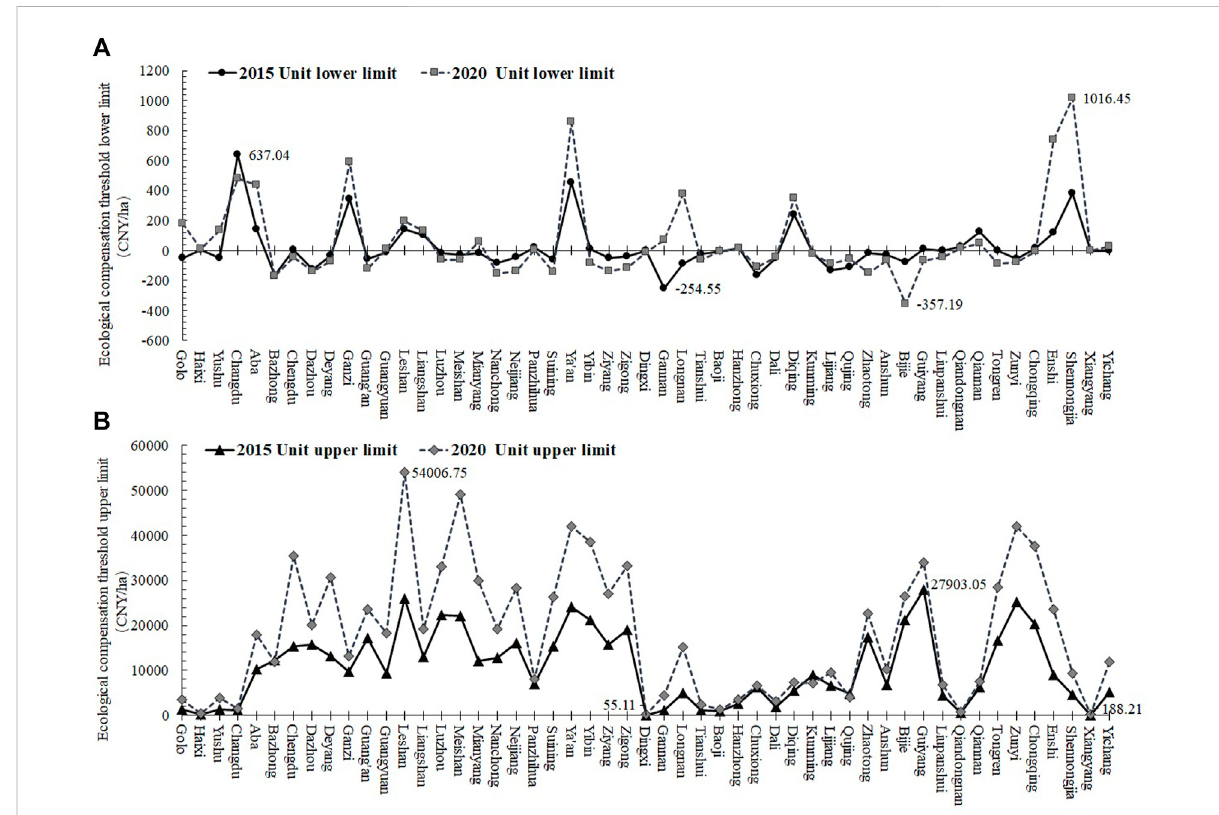
FIGURE 8 Ecological compensation unitthreshold inthe upper Yangtze River. (A) Lower limit of unitthresholdin prefecture-level cities; (B) Upper limit of unit threshold in prefecture-level